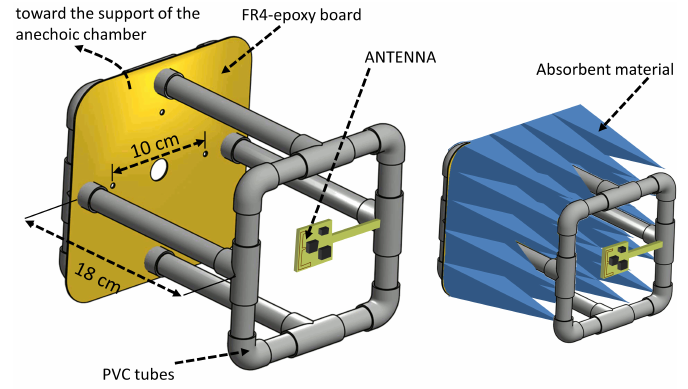
Figure 4. Non-conductive PVC support for anechoic chamber measurements.